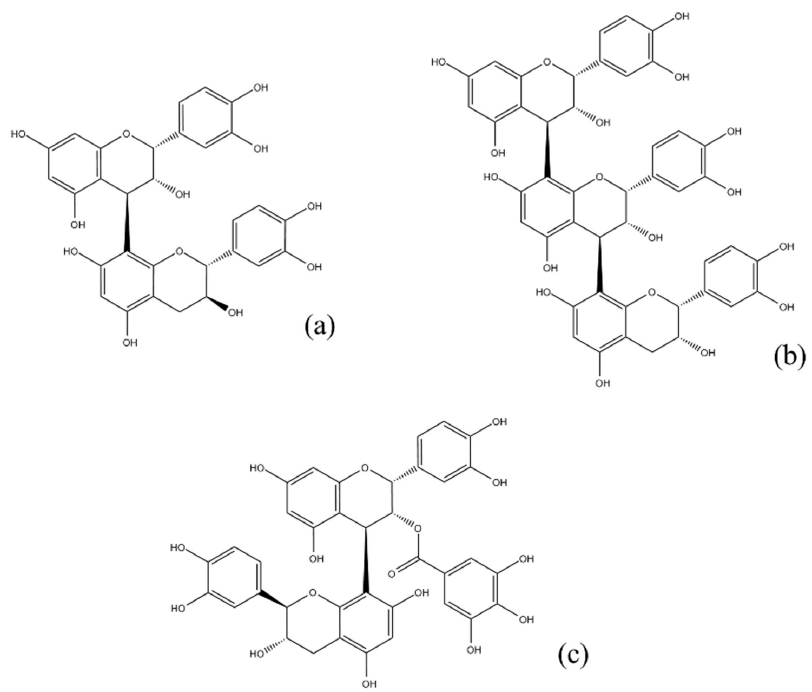
Figure 1. Most common proanthocyanidins in cacao and grape seed extracts: procyanidin dimer ( a ); procyanidin trimer ( b ); and procyanidin dimer gallate ( c ).